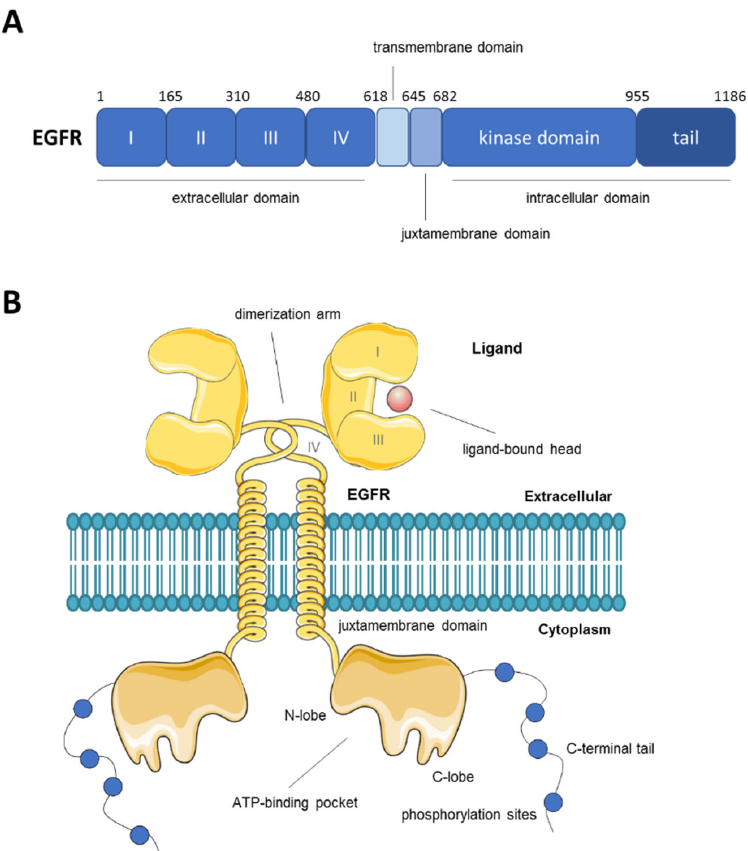
Figure 1. Schematic representation of human EGFR structure and domains. ( A ) Domain boundaries in EGFR with amino acid positions. ( B ) Depiction of the structure of the EGFR dimer in the cell membrane with indication of its various domains and functions.